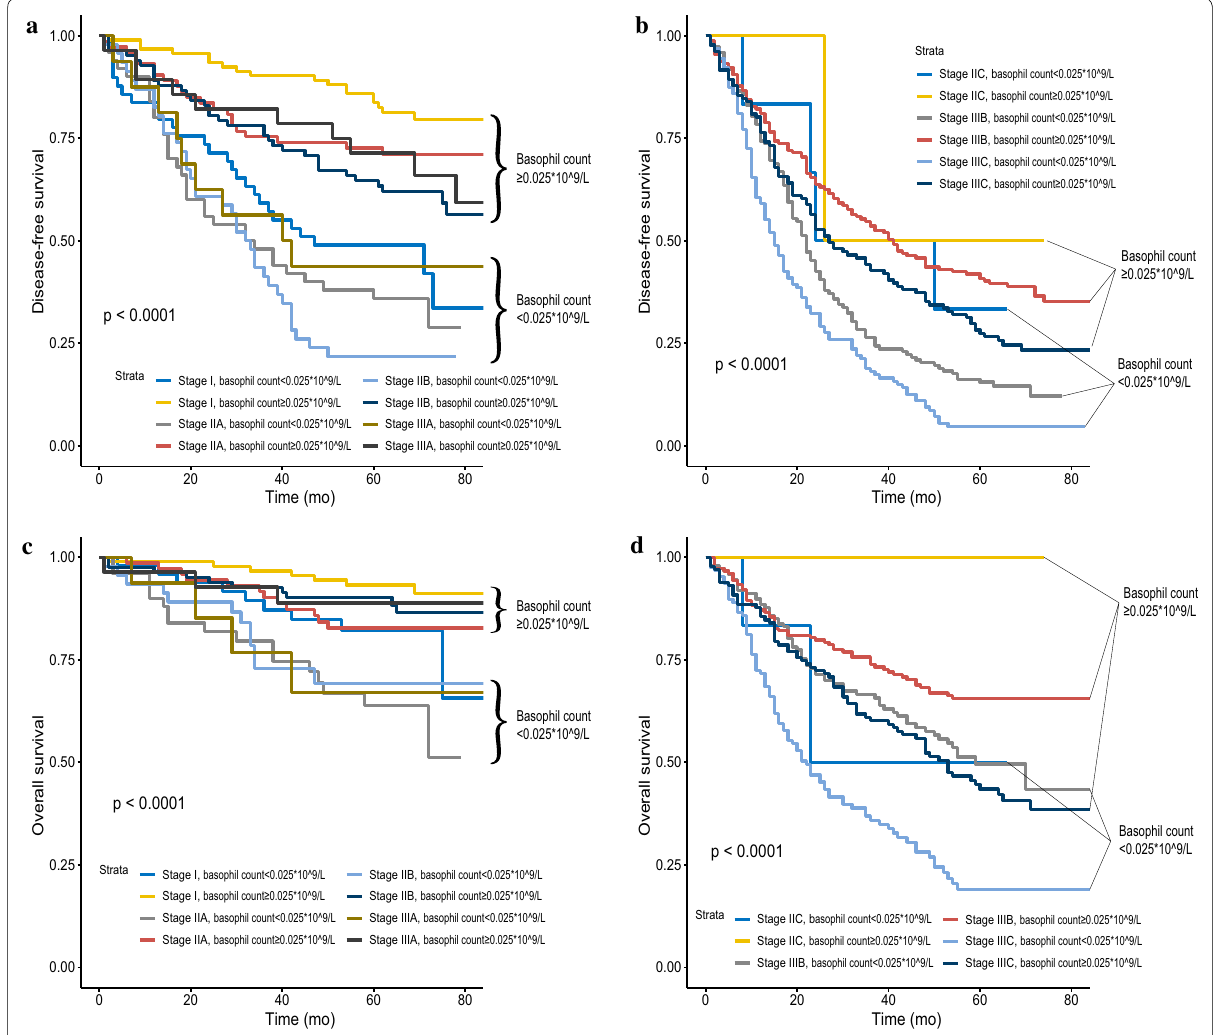
Fig. 3 Kaplan–Meier survival curves of the serum basophil count level in respective AJCC TNM staging system, including DFS of ( a ). stage I, stage IIA, stage IIB and stage IIIA ( b ). stage IIC, stage IIIB and stage IIIC; and OS of ( c ). stage I, stage IIA, stage IIB and stage IIIA ( d ). stage IIC, stage IIIB and stage